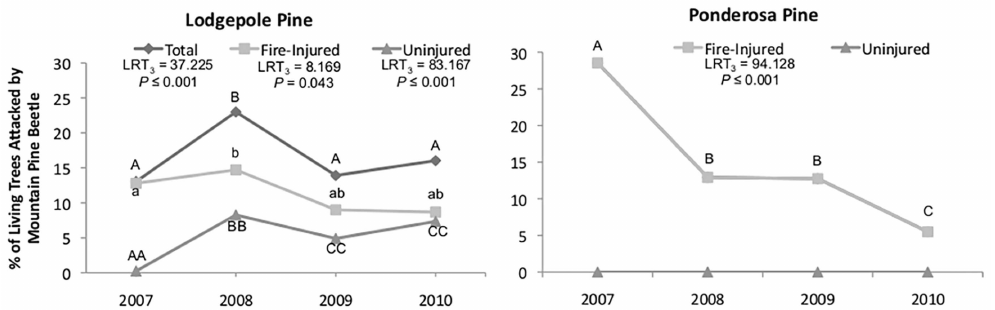
Fig 5. Percent of lodgepole (left) and ponderosa (right) pines that were mass- or strip- attacked by mountain pine beetles over four years. The fire occurred in 2007, prior to beetle flight. Attacks occurred on uninjuredand fire-injuredlodgepolepine, whereas only fire-injuredponderosa pines were attacked. Different letters denote significant differences ( α (cid:20) 0.05) between years within a tree category from generalizedlinear mixed models with Tukey HSD pairwise